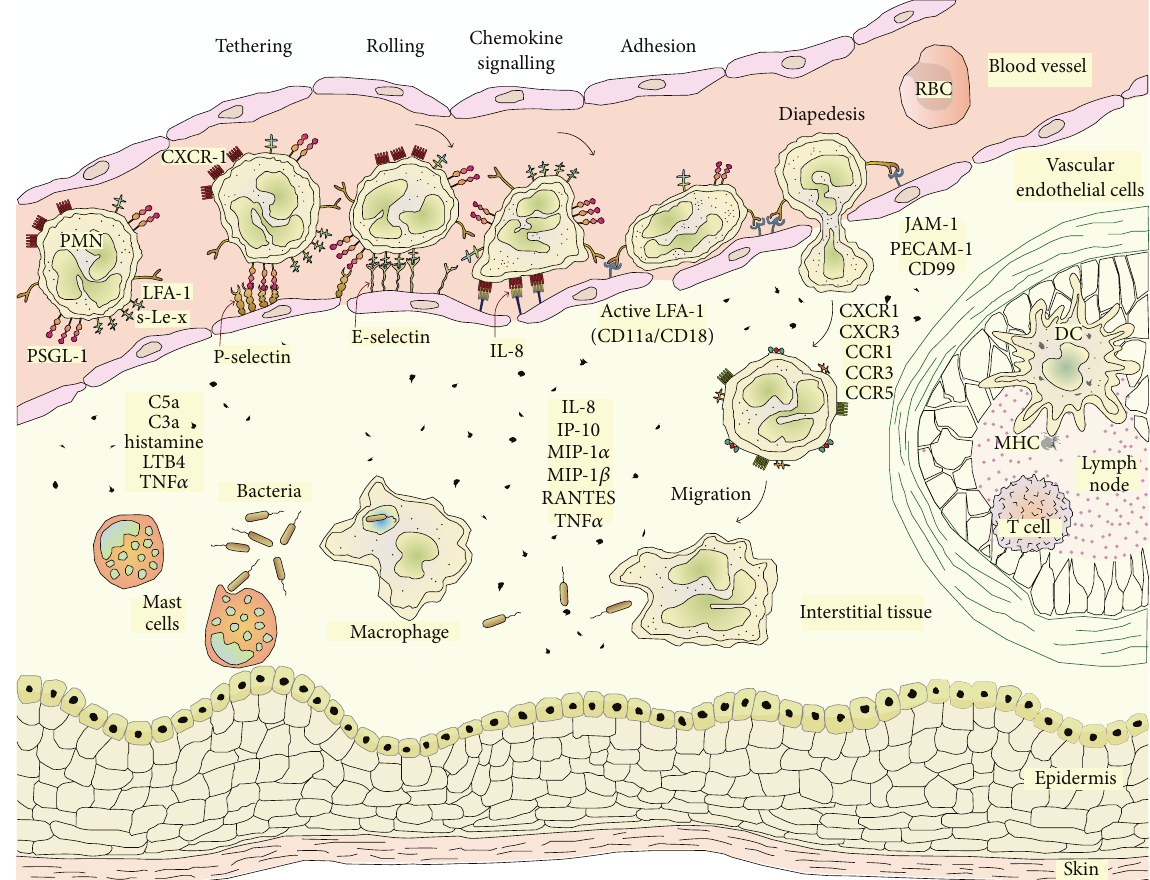
Figure 1: Schematic representation of an immune response to a bacterial infection. Tethering: P-selectins bind to PSGL-1 and tether PMN. Rolling: P-selectins bring PMN near E-selectins and slow rolling commences. Chemokine signalling: slow rolling allows IL-8 binding to CXCR1, then integrin activation results in more adhesive interactions with endothelial ligands. Adhesion: activated LFA-1 binds ICAM-1 or ICAM -2 for firm adhesion. Diapedesis: PMN begins diapedesis by exchanging tight junction molecules with endothelial cells. Migration: PMN follows a gradient of inflammatory chemokines to pathogens. Attack: complement attacks the incoming pathogens, mast cells, and macrophage phagocytose pathogens; toll-like receptor molecules trigger inflammation; antigen presenting dendritic cells express MHC molecules to activate T lymphocytes and to recruit neutrophils. PMN = polymorphonuclear neutrophil; CXCR/CCR = chemokine receptor; s-Le-x = sialyl-Lewis X; LFA = lymphocyte function-associated antigen; PSGL = P-selectin glycoprotein ligand; IL = interleukin; CD = cluster of differentiation; CD11a/CD18 = integrins; RBC = red blood cell; JAM = junctional adhesion molecule; PECAM = platelet endothelial cell adhesion molecule; DC = dendritic cell; MHC = major histocompatibility complex; T cell = T lymphocyte; IP-10 = interferon-gamma induced protein-10; MIP = macrophage inflammatory protein; RANTES = regulated on activation, normal T cell expressed and secreted